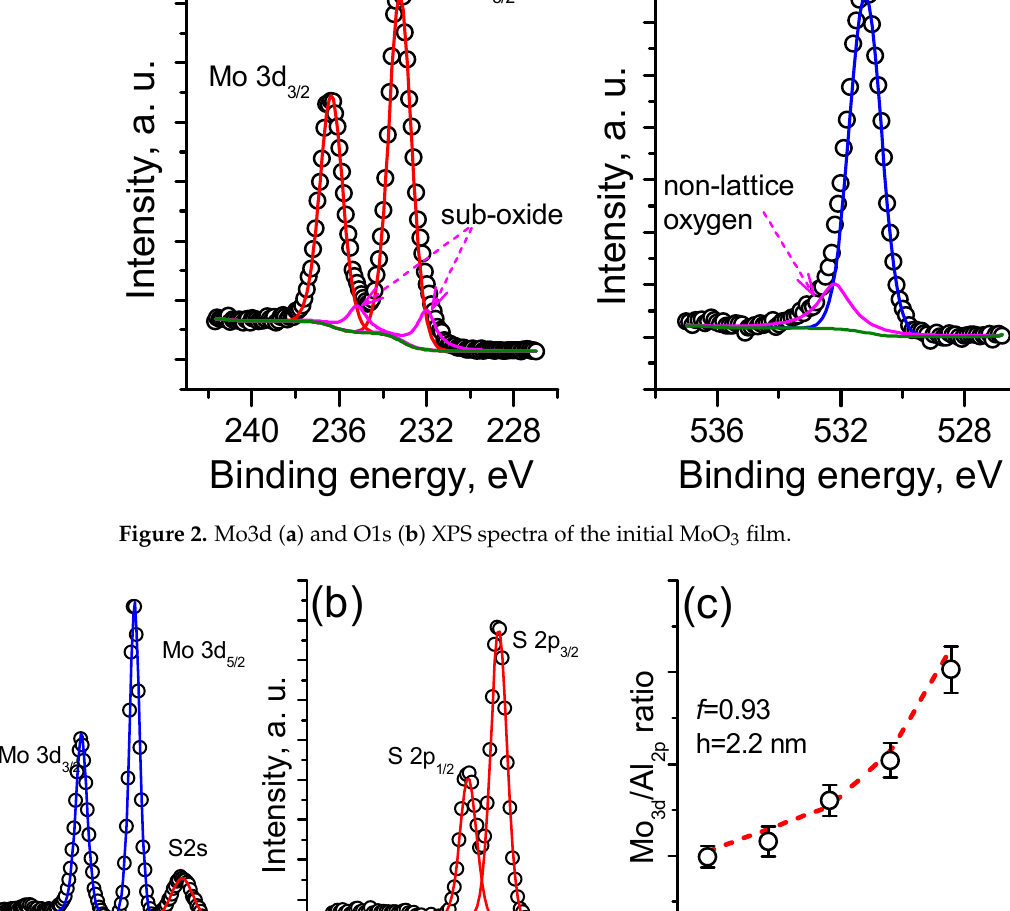
Figure 3. XPS spectra of Mo3d ( a ) and S2p ( b ) lines measured from the sulfurized MoO 3 film; Mo3d/Al2p signal ratio as a function of the electron emission angle Θ ( c ).